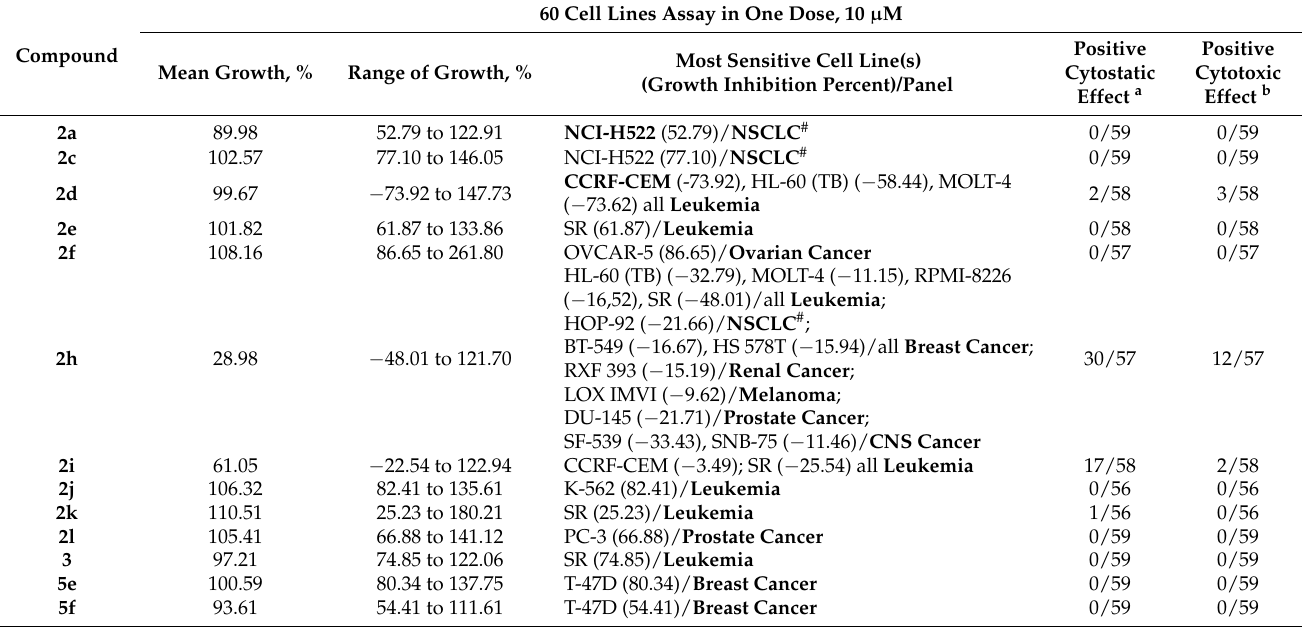
NSCLC # : Non-Small Cell Lung Cancer. a Ratio between number of cell lines with percent growth from 0 to 50 and total number of cell lines. b Ratio between number of cell lines with percent growth of <0 and total number of cell